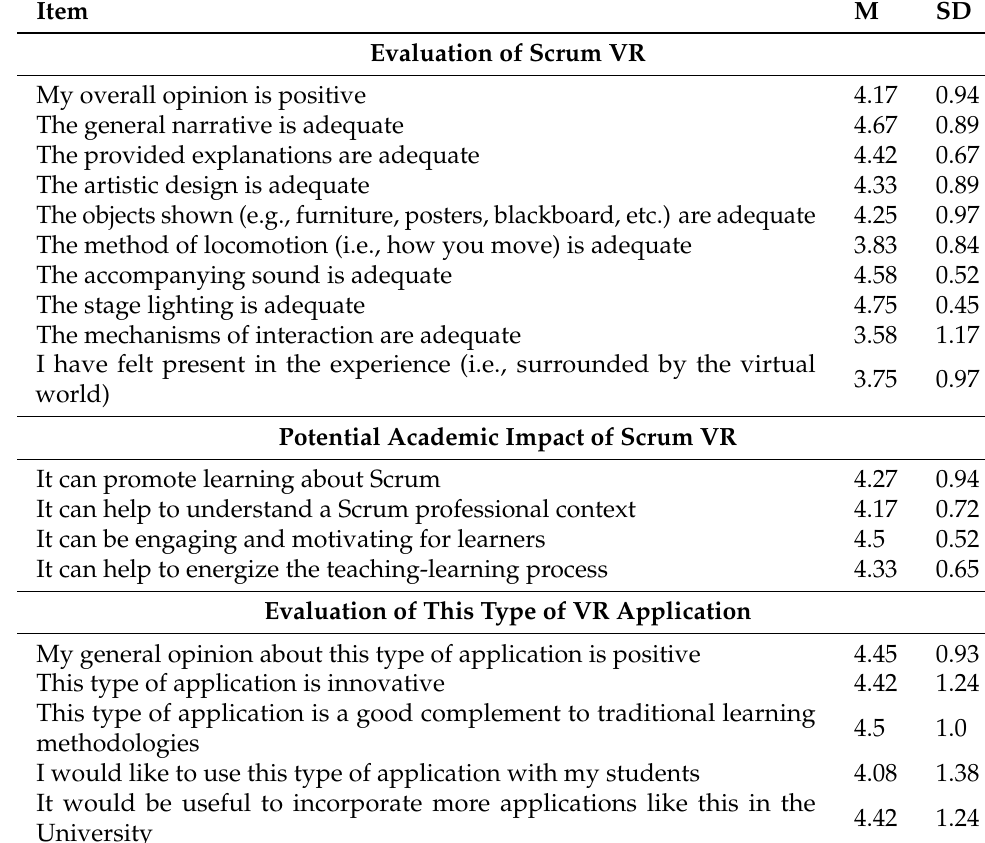
Table 1. Quantitative results: Teacher’s